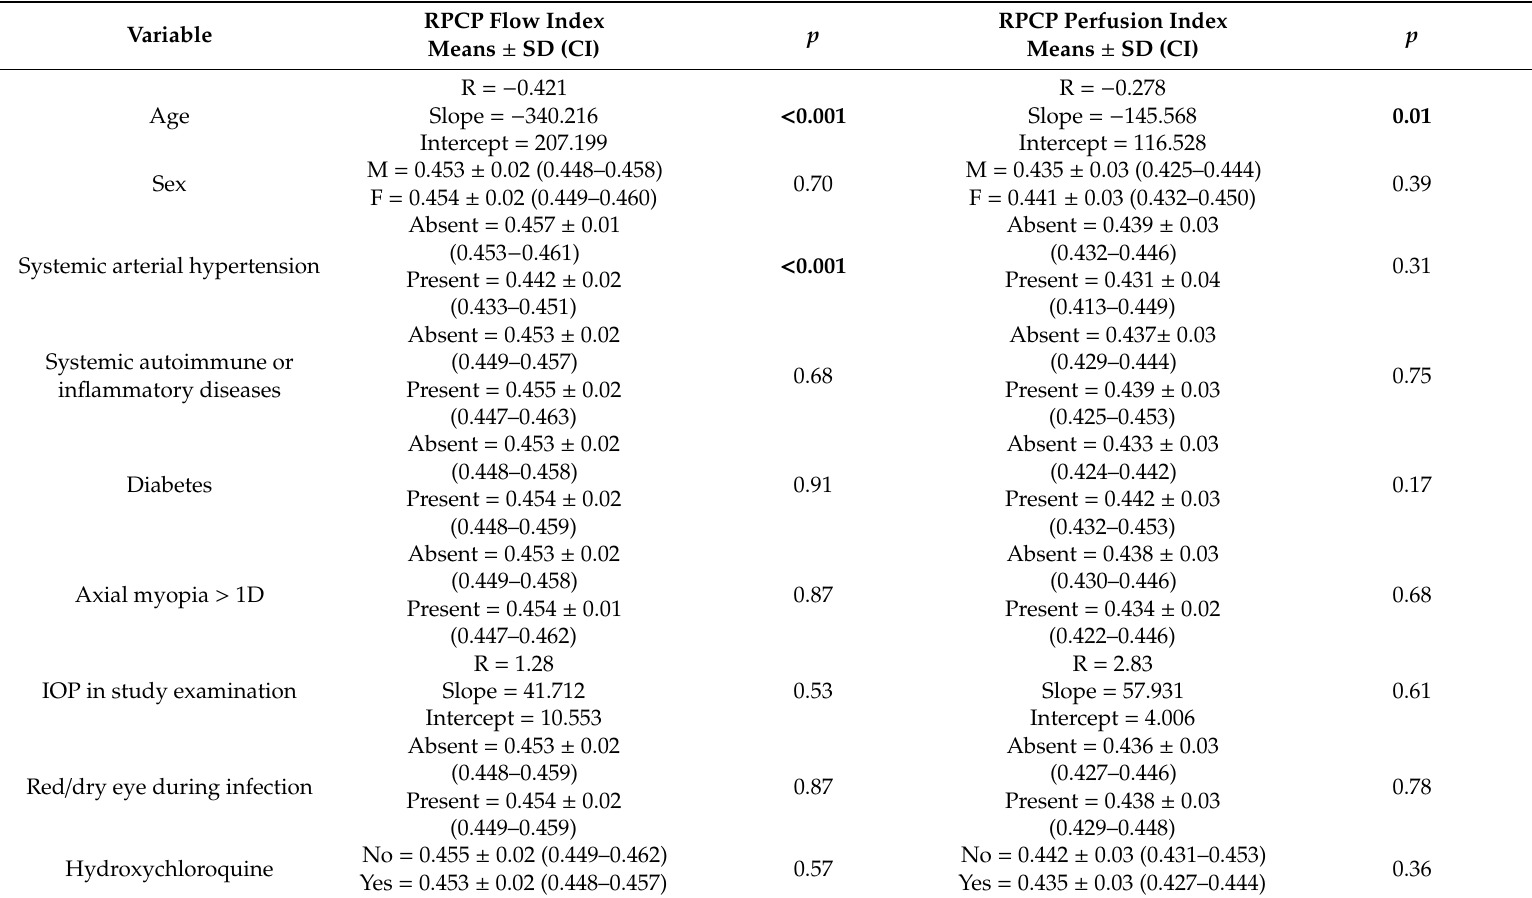
Table 4. Analysis of the variations of the primary outcome measures within the post-COVID-19 according to the other examined variables. The drugs and clinical complications occurred during the hospital recovery are